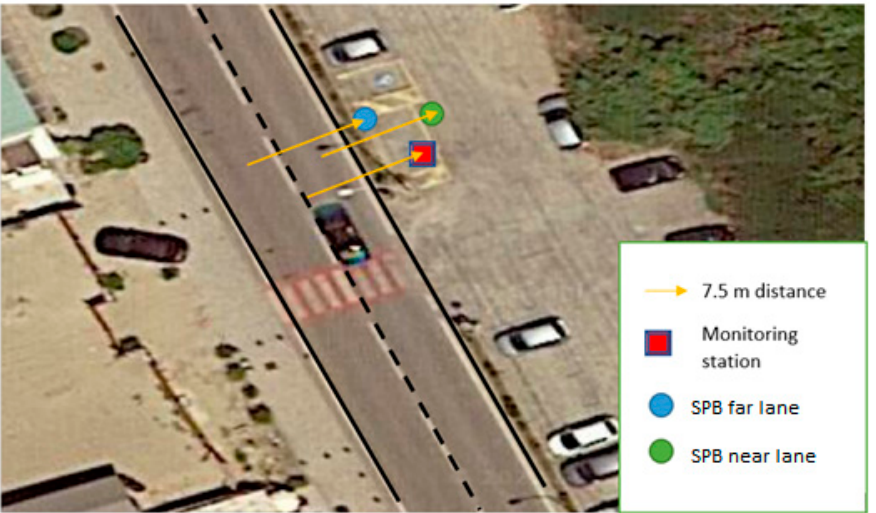
Figure 2. Measurement setup in T1 (Marina di Pisa). Near lane is the one close to the traffic counter and monitoring station; far lane is the one in the opposite direction.